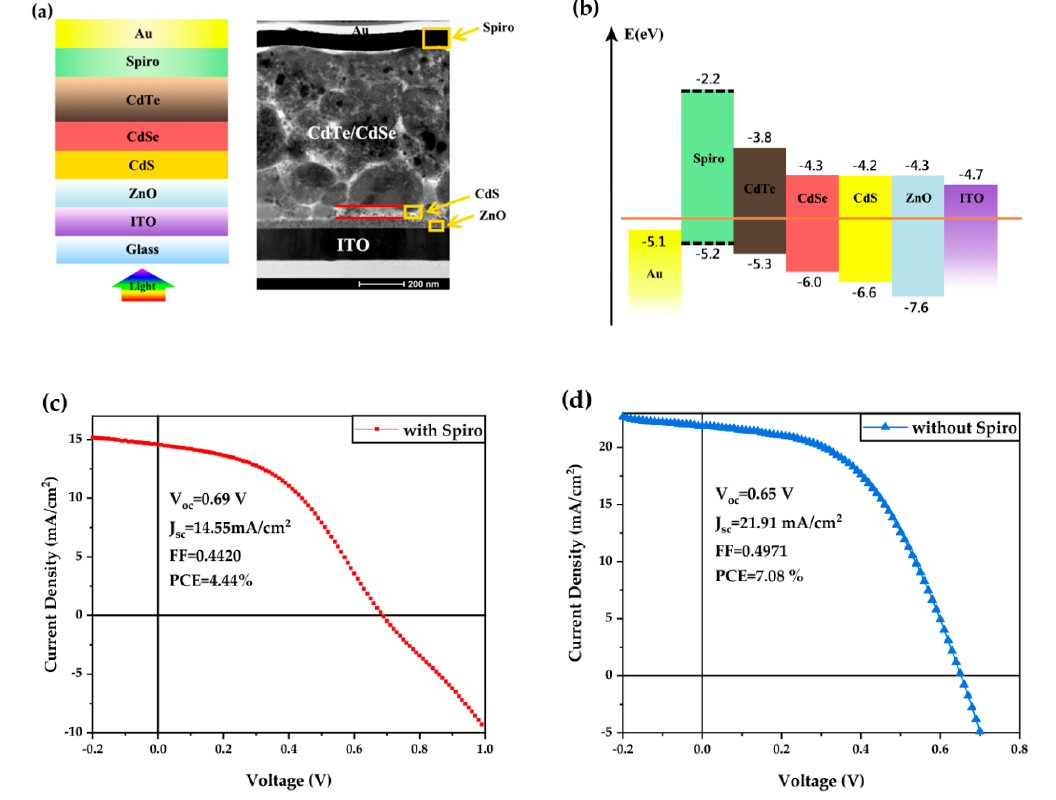
Figure 4. ( a ) The NC solar cell configuration and bright-field (BF) transmission electron microscope (TEM) cross-sectional image of the corresponding device; scale bar: 200 nm; ( b ) band alignment of the NC solar cell with the Spiro hole transfer layer (HTL); ( c ) current density vs voltage ( J–V ) curve of NC solar cells with the Spiro HTL (prepared at room ambient condition) and ( d ) J–V curve of the control device (without using the Spiro HTL).